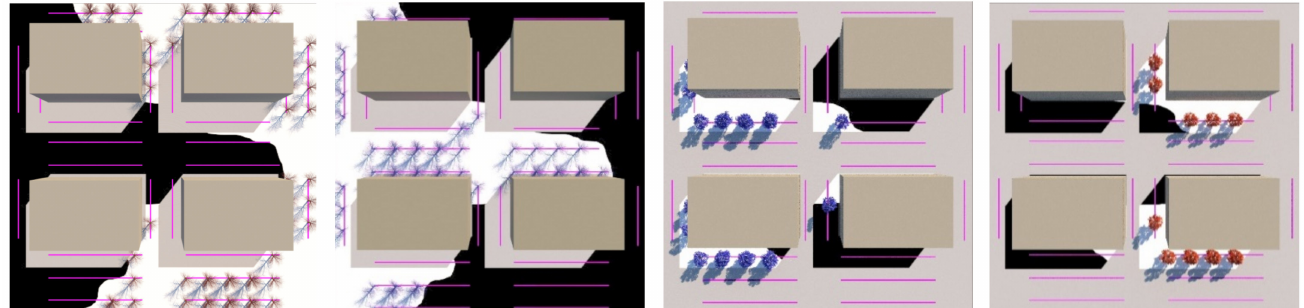
Figure 9. Shows tree models suppressed in the black sections of the map. In this map, black represents areas that are both overshadowed by buildings and affected by floods. The tree models are then only allowed to occur in the white areas representing conditions where winter solar access is possible, and flooding does not occur. The three other condition maps control the suppression or occurrence of trees in each proxy-object tree scatter. NOTE: due to the use of the ‘masking operation’, beige also works as a black suppression area. Image by authors using multi-criteria street design decision support modelling approach in Autodesk™ 3ds Max™.